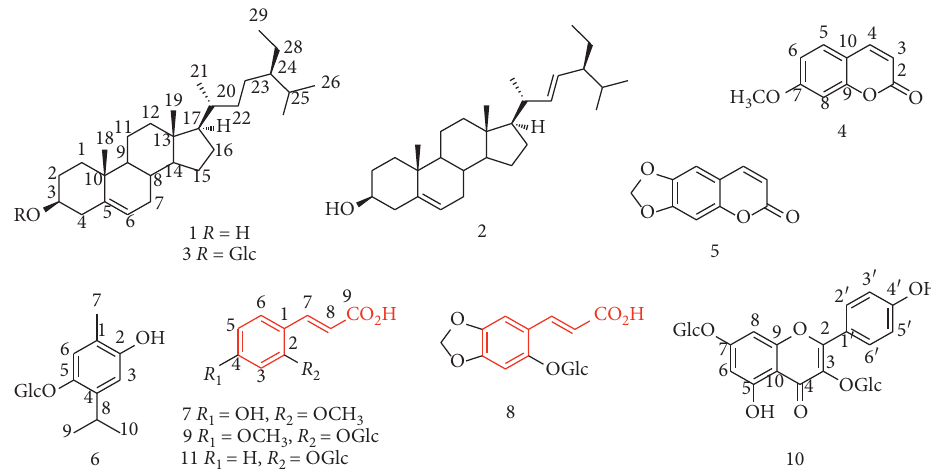
Figure 1: Structures of compounds 1–10 from E. triplinerve and 11 from E. japonicum .